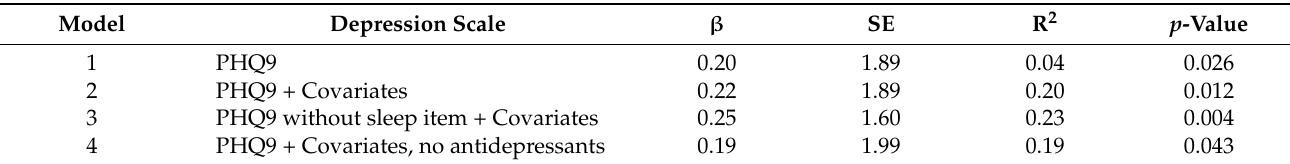
Table 2. Linear regression models of Apnea Hypopnea Index in early pregnancy predicting depressive symptoms in late